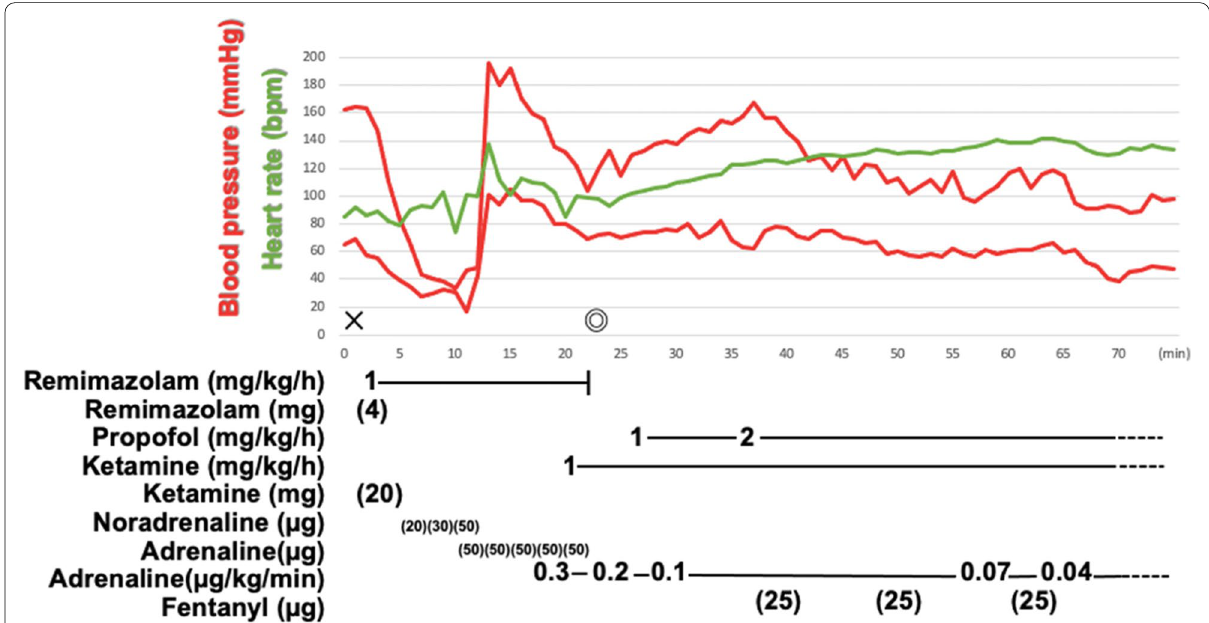
Fig. 1 Time course of general anesthesia in case 1. We stopped adrenaline infusion at the end of